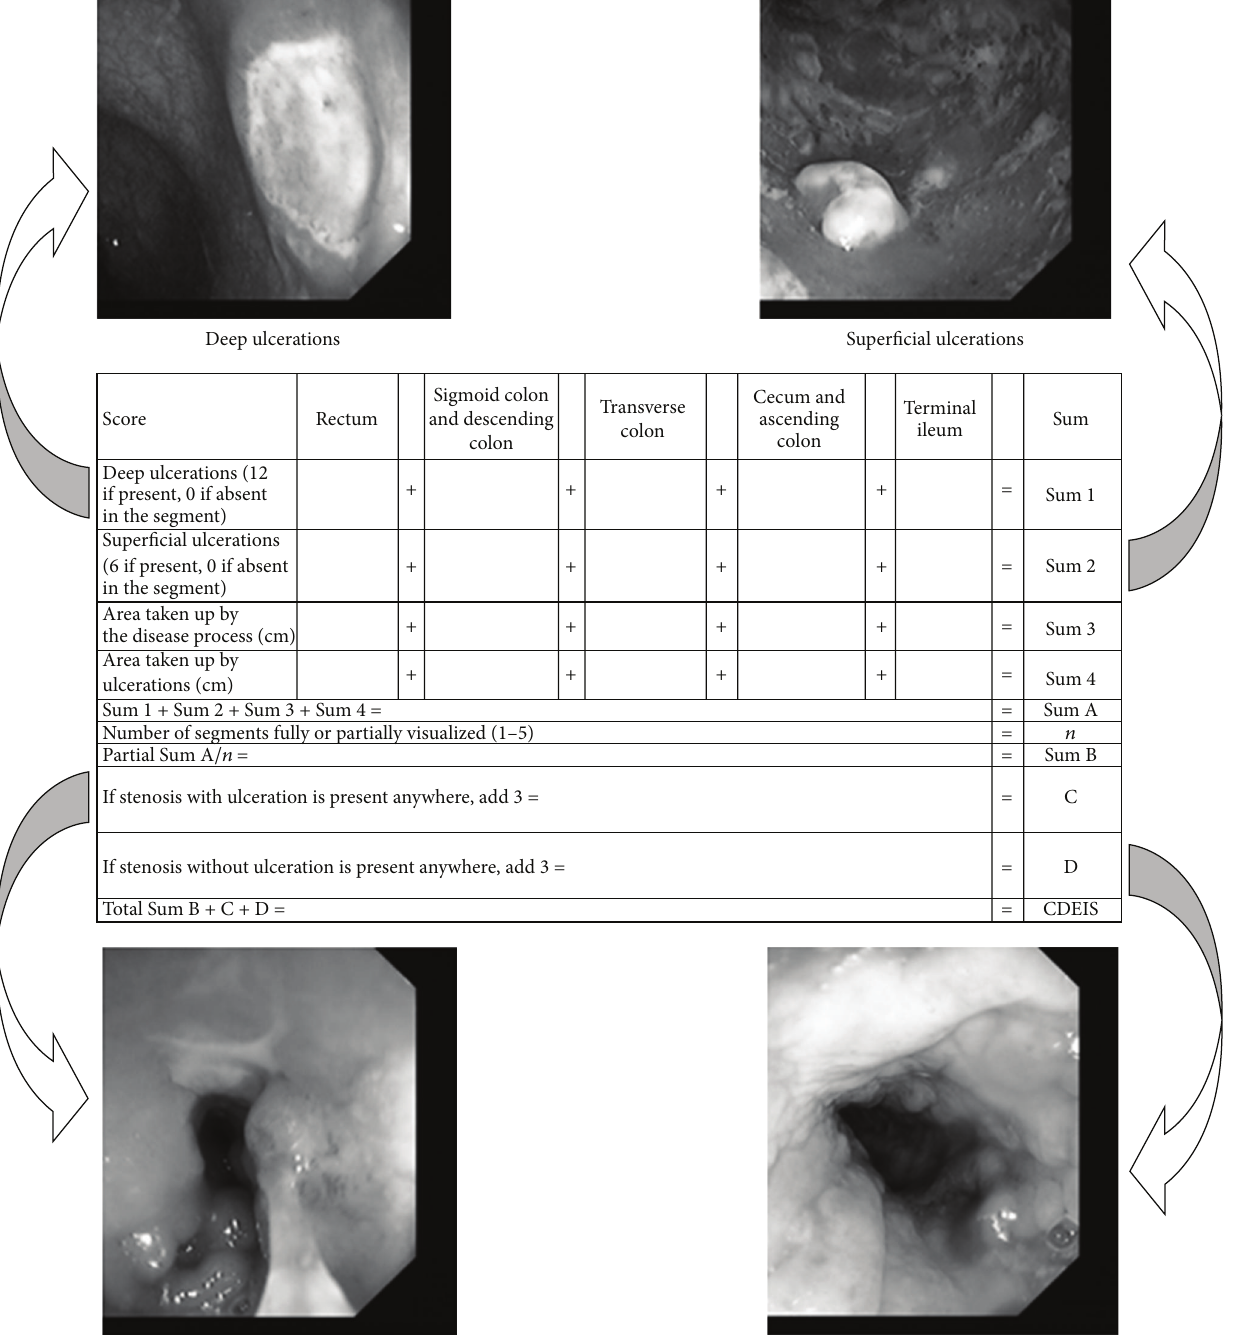
the correlation coefficient belongs to the 0.26–0.49 range, then the correlation of traits is low (low correlation); (iii) if the correlation coefficient belongs to the 0.50–0.69 range, then the correlation is moderate (moderate